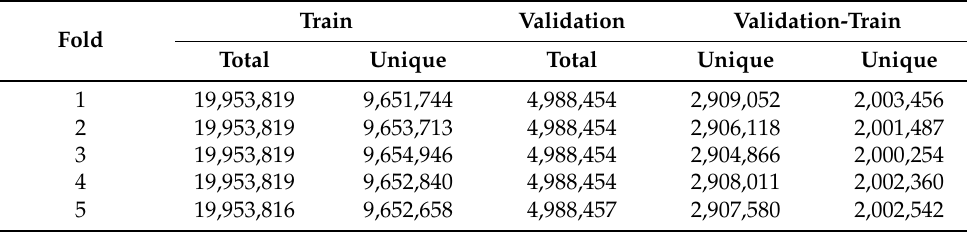
Table 1. The data of the 5-fold cross-validation.